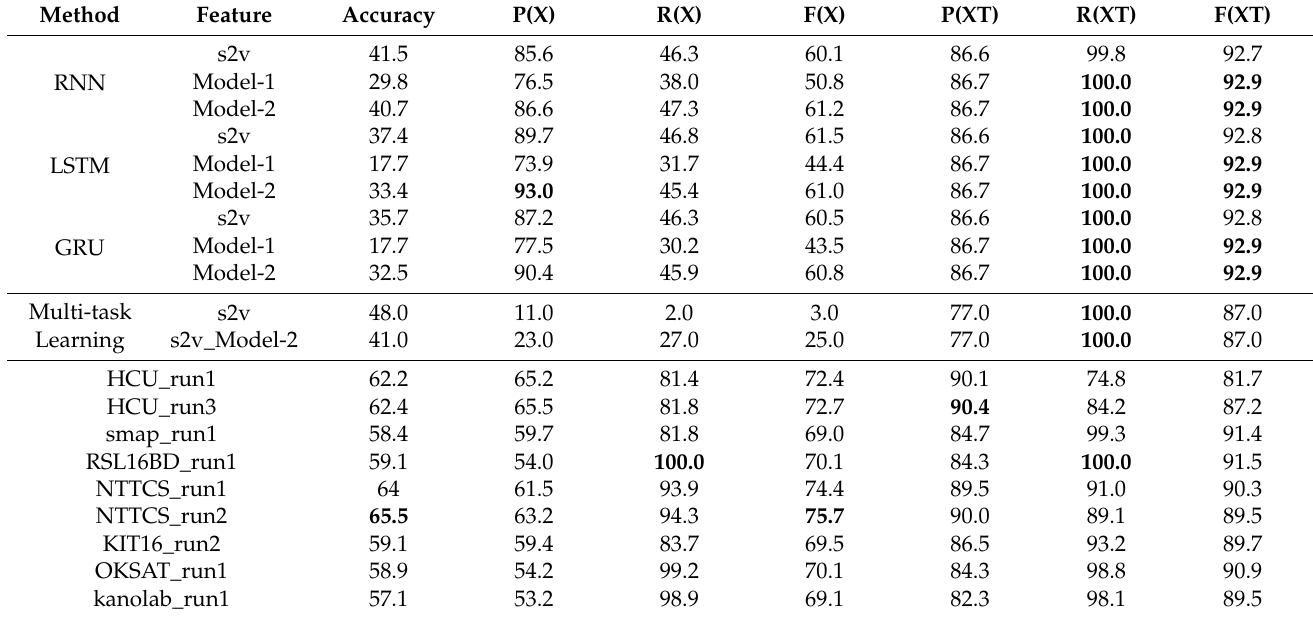
Table 14. Comparison with the other methods presented in DBDC2 (DIT).